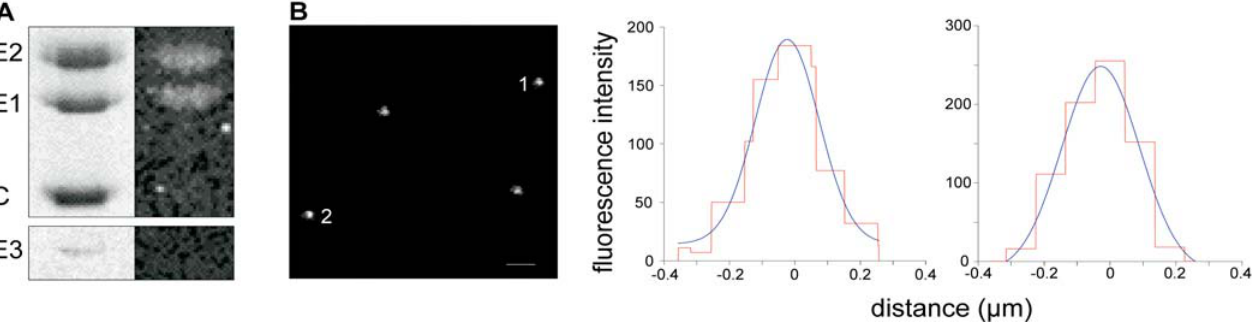
Figure 1. Fluorophores Label Glycoproteins E1 and E2 of SFV (A) Analysis of SFV-FITC by non-reducing SDS-PAGE with Coomassie blue staining in the left lane and fluorography in the right lane. E1 (49 kDa) and E2 (52 kDa) are the only proteins that are fluorescently labeled; capsid protein C and E3 are not. (B) Confocal microscopy of Cy5-labeled SFV, showing individual spots of uniform size (approximately 0.4 l m). The relative fluorescence intensity distribution of two spots is shown. The distribution of the fluorescence fits to a Gaussian function. (Fit is calculated using the equation: y ¼ e (cid:1) x 2 .) Scale bar represents 1 l m. DOI: 10.1371/journal.pbio.0030233.g001 PLoS Biology |